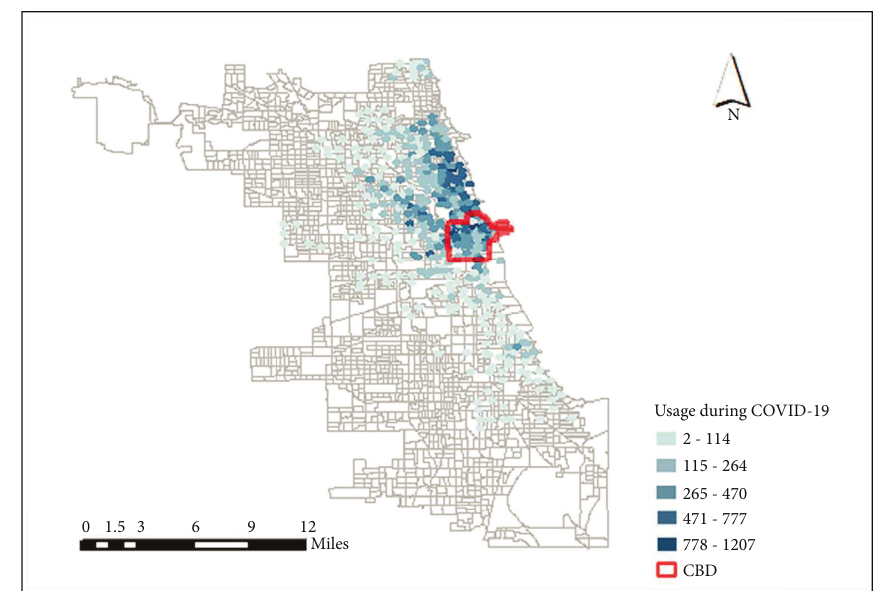
Figure 6: Spatial distribution of Divvy usage during COVID-19.